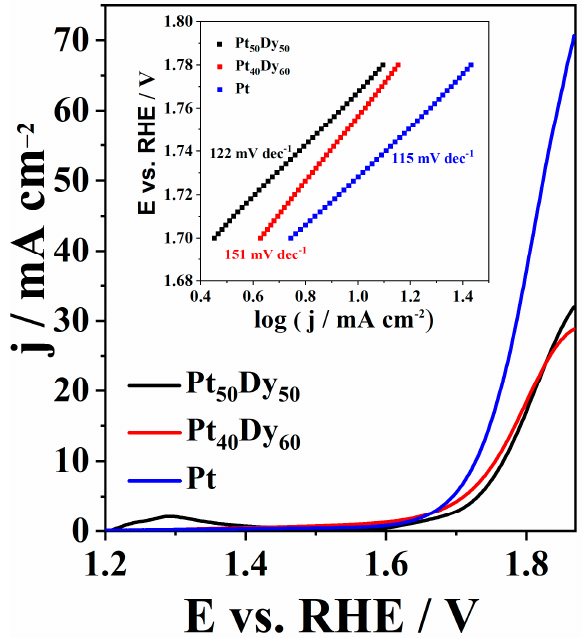
Figure 4. OER polarization curves of the Pt 50 Dy 50 , Pt 40 Dy 60 , and Pt electrodes in 1 M NaOH at a scan rate of 20 mV s − 1 and 25 °C, with the corresponding Tafel slopes on the inset.